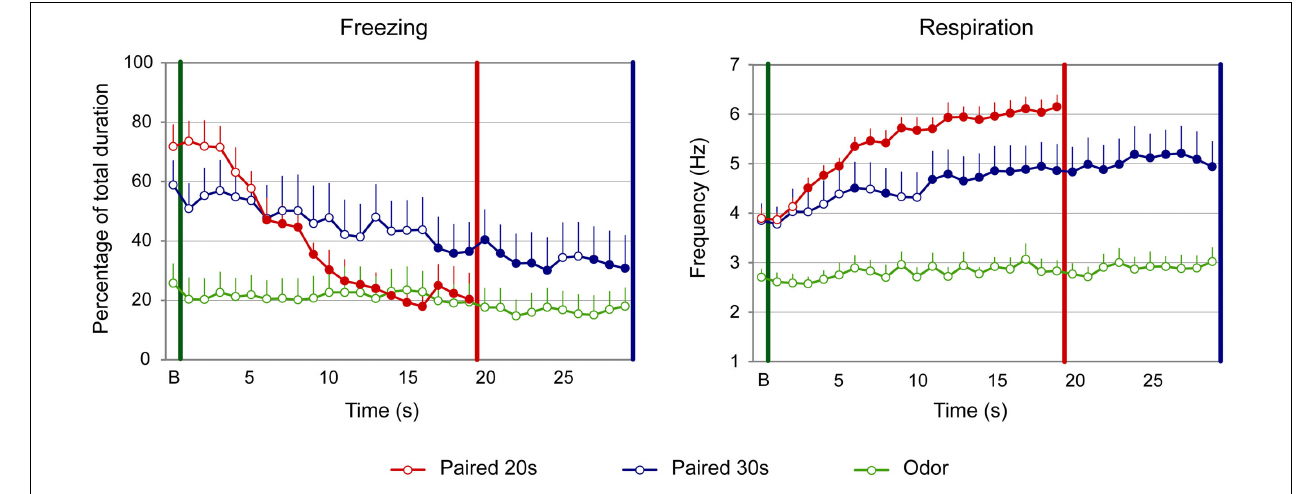
FIGURE 5 | Effect of odor-shock conditioning on fine-grain temporal pattern of freezing and respiration during odor presentation in infant pups. The temporal pattern is represented with a 1-s bin precision, from the odor onset (green vertical line on each graph) to shock arrival (red and blue